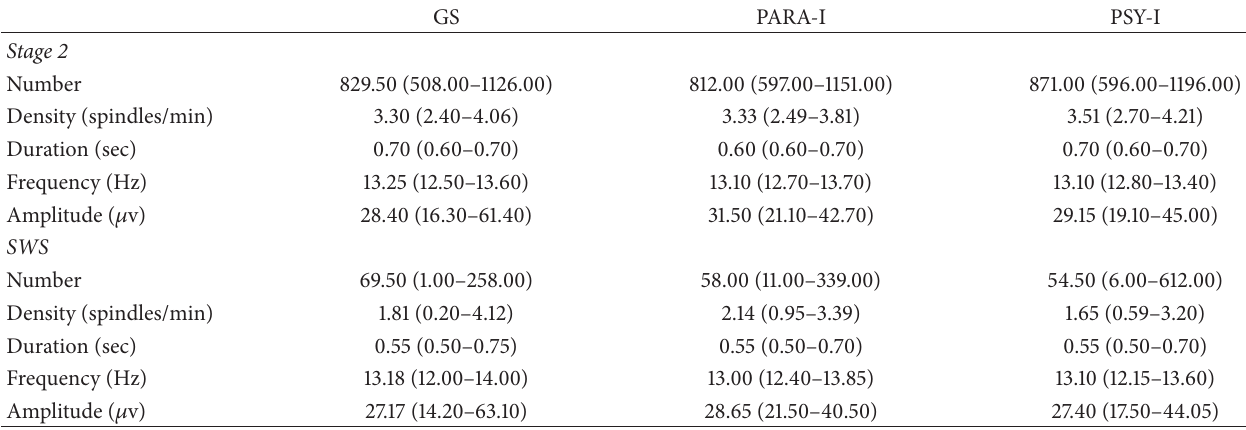
Table 3: Characteristics of sleep spindles for good sleepers (GS) and paradoxical (PARA-I) and psychophysiological (PSY-I) insomnia sufferers.